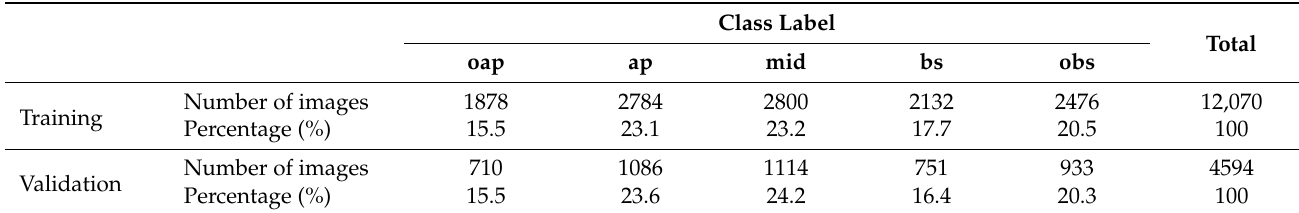
Table 3. The number of images for each class label in training and validation datasets.